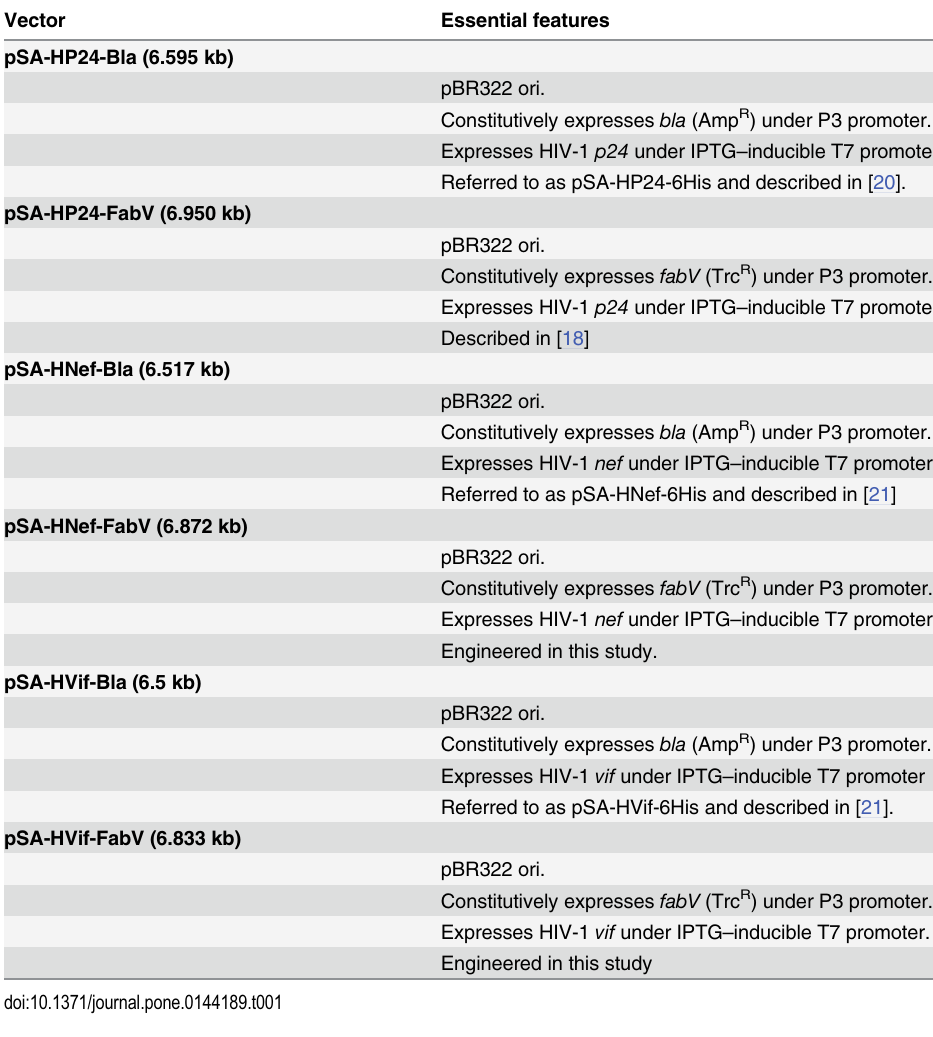
Table 1. Plasmid vectors used in this